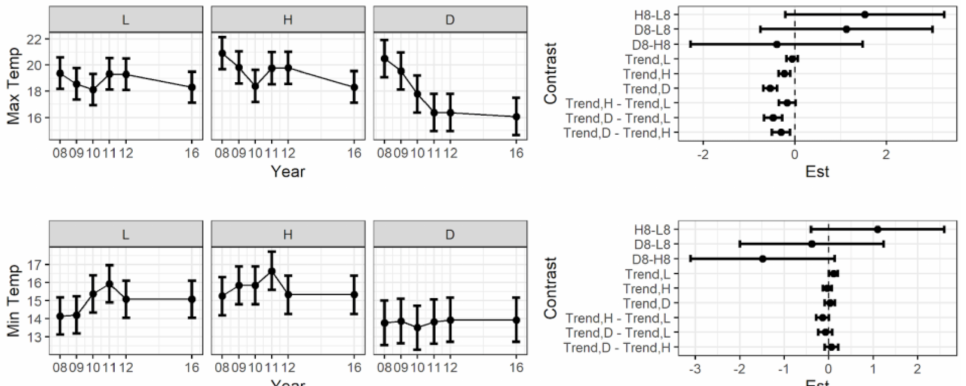
Figure 4. Estimated marginal means with 90% C.I.s of mean maximum temperature and minimum temperature in summer after 2008 to 2016 at low flood ( L ), high flood ( H ), and debris flow ( D ) disturbance categories (left) and sets of contrasts differences in 1st year response (1–3), differences in trend through time (4–6), and of differences in trend between categories (7–9) (right